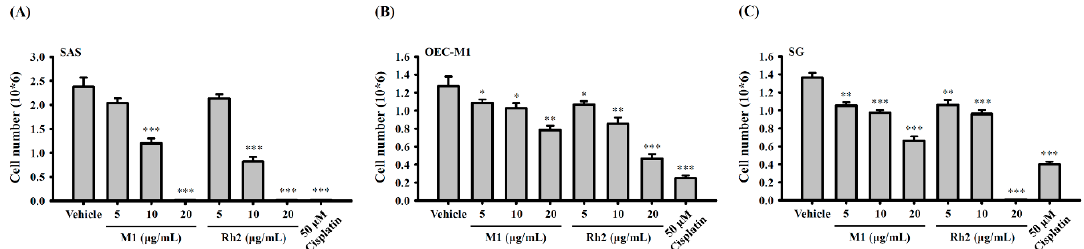
Figure 2. Ginsenoside M1 induced cell death of human oral cancer cells. SAS cells ( A ), OEC-M1 cells ( B ), and SG cells ( C ) were incubated for 24 h with ginsenoside M1, ginsenoside Rh2, cisplatin, or vehicle. The cell numbers were counted by Trypan blue exclusion method. The data were expressed as mean ± SD; n = 3. *, **, and *** indicate a significant difference at the level of p < 0.05, p < 0.01, and p < 0.001, respectively, compared to vehicle-control cells. (One-way ANOVA with Dunnett’s multiple comparisons test).